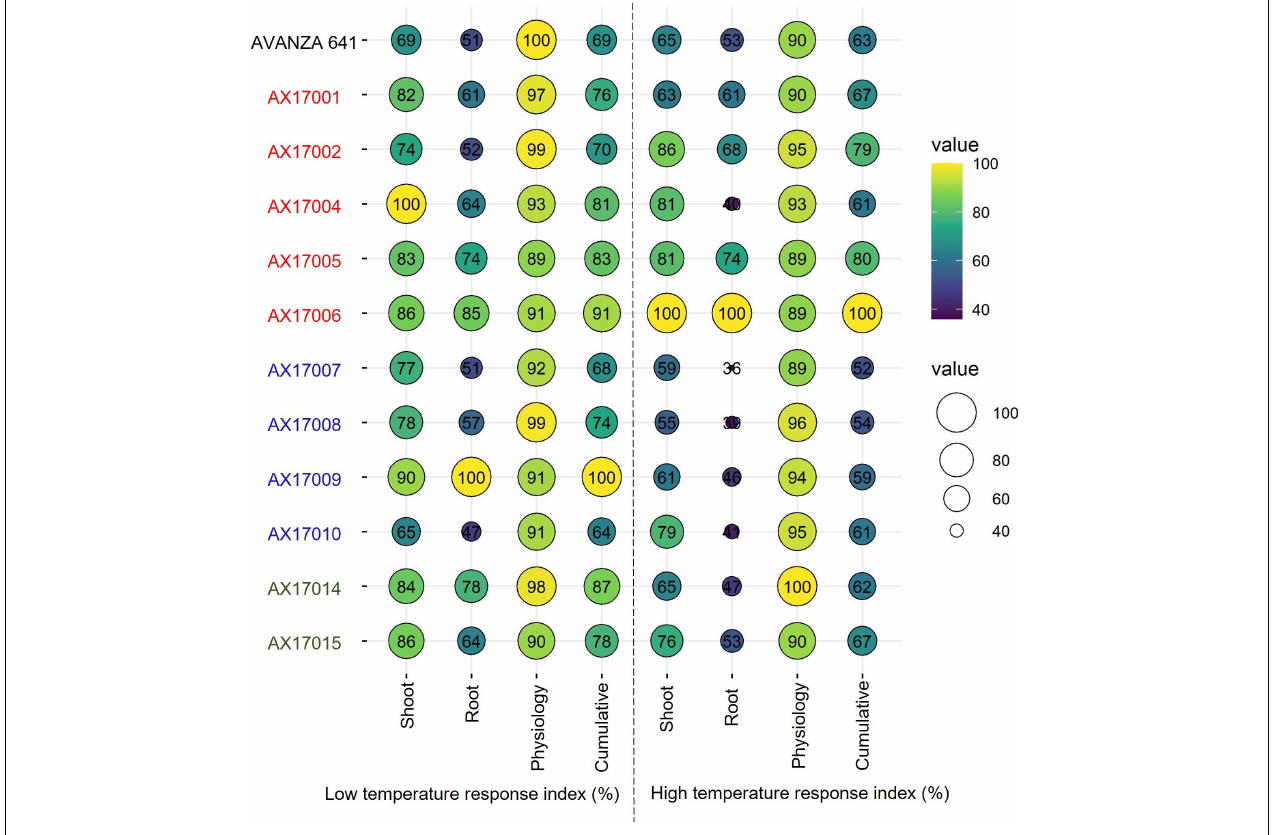
FIGURE 6 | Bubble plot showing cumulative shoot, root, physiological, and cumulative low-temperature response index or high-temperature response index of 12 advanced Brassica carinata genotypes measured 35 days after planting or 24 days after temperature treatments. The colors of the genotypes represent four Brassica carinata breed types ( black – cultivar or commercial check, red – inbred, blue – double haploid, and green – hybrid) used in the